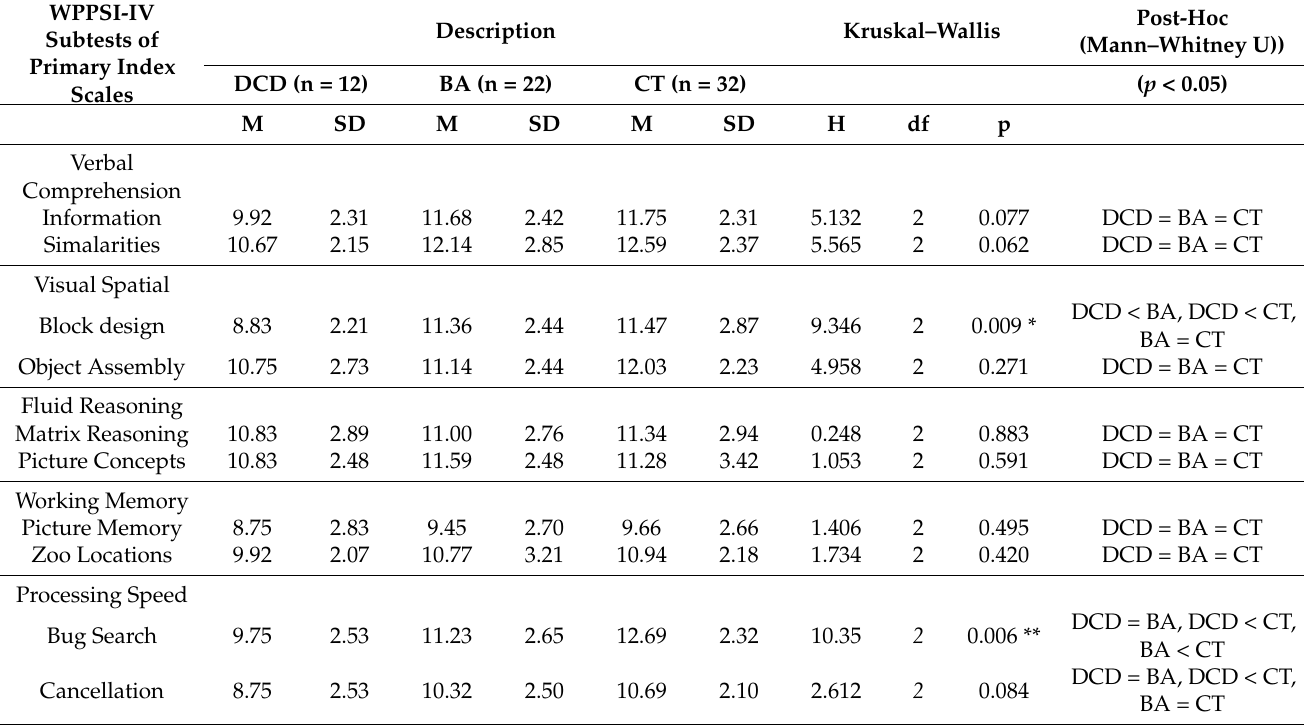
Table A2. Mean and standard deviation for all subtests of the primary WPPSI-IV indices by group and results of Kruskal–Wallis test and Mann–Whitney